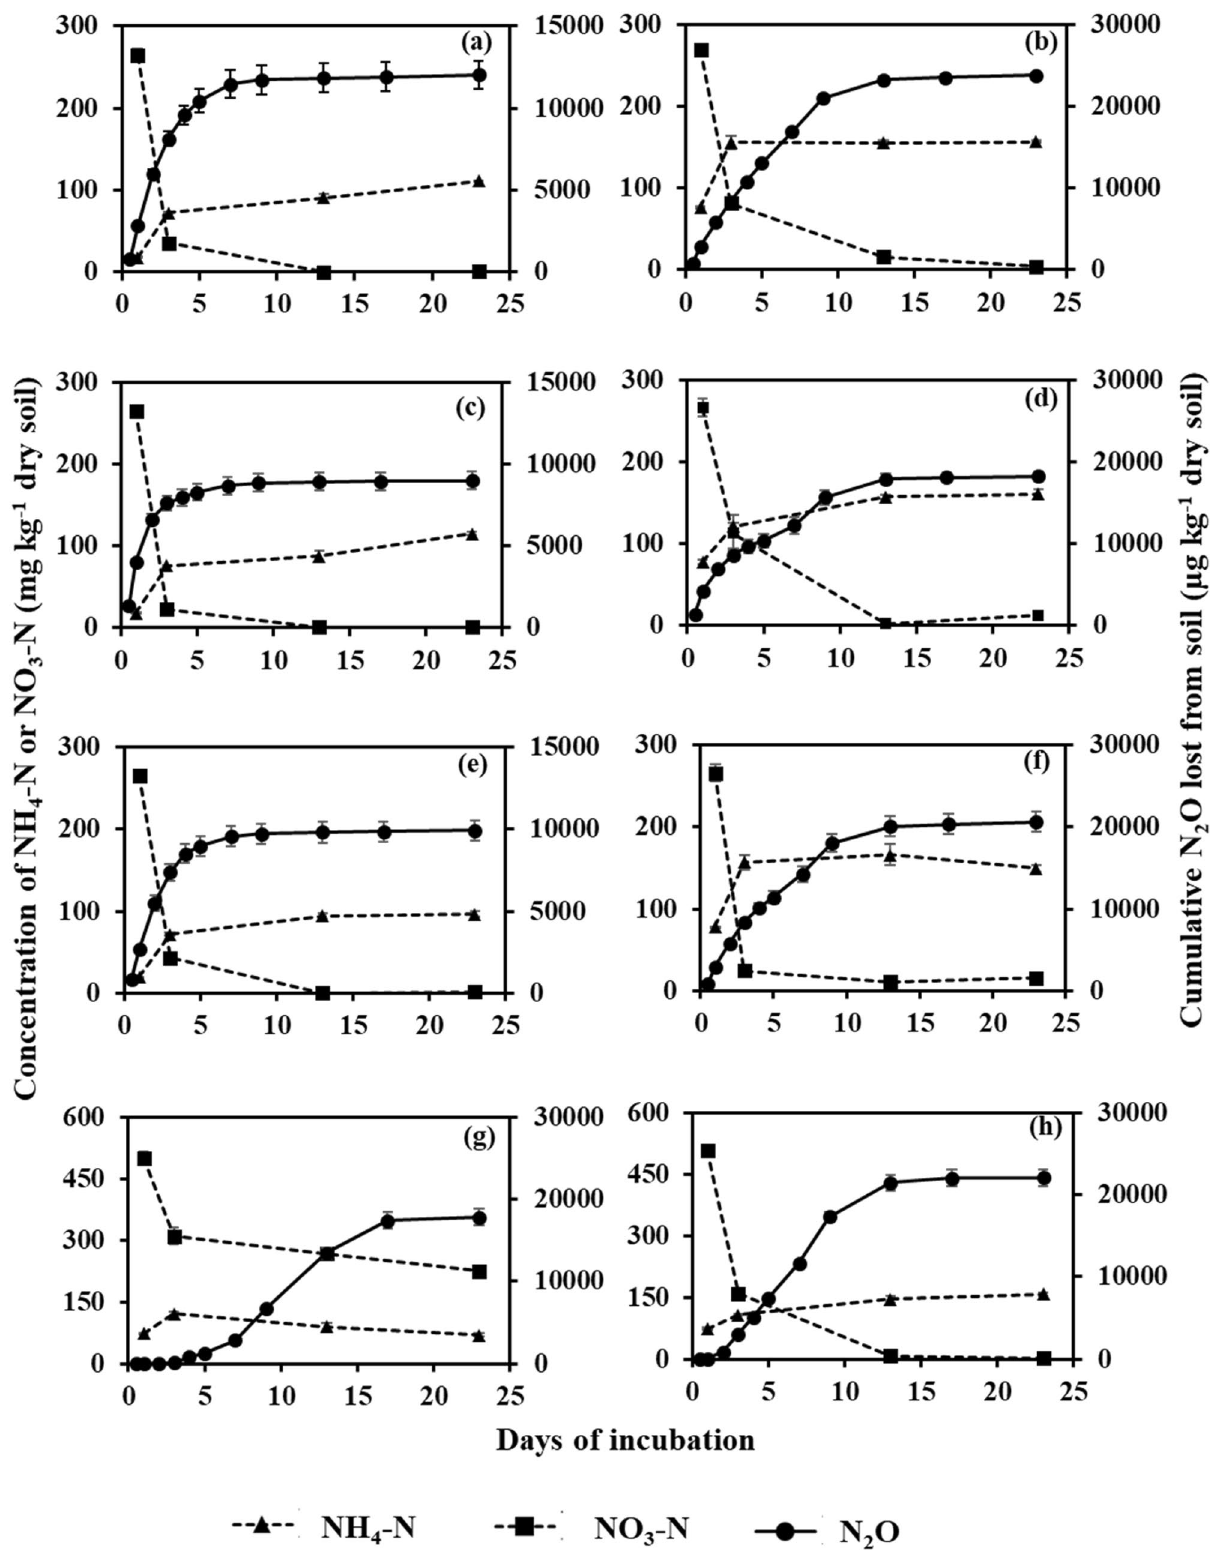
Figure 4. Cumulative N 2 O production, and mineral N concentration (NH 4+ and NO 3− ) in organic soil (OS). A = Control soil only (S); b = Control soil with N fertilizer (S + N); c = Control soil with corn residue biochar (S + CB); d = Control soil with corn residue biochar and N fertilizer (S + CB + N); e = Control soil with pine bark biochar (S + PB); f = Control soil with pine bark biochar and N fertilizer (S + PB + N); g = Control soil with N fertilizer and calcium peroxide (S + N + CPO); h = Control soil with N fertilizer and magnesium peroxide (S + N + MPO). Bar represents standard error, n =